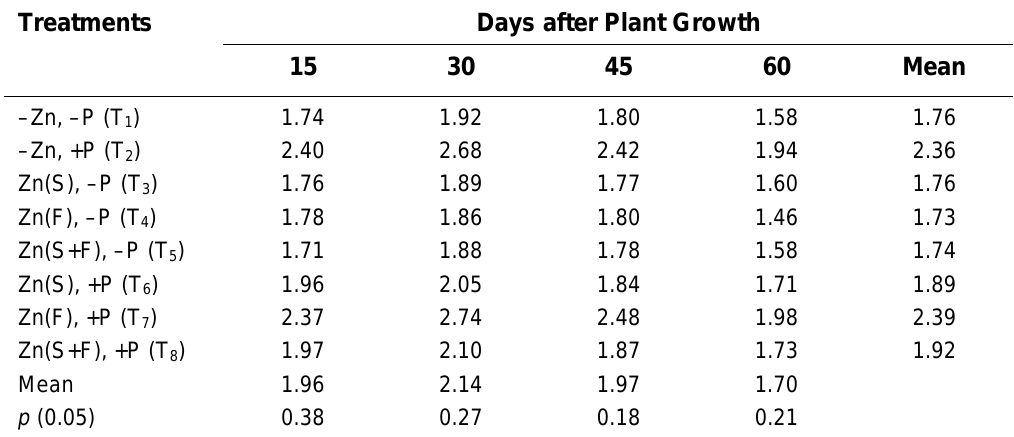
Interaction Effect Between P and Zn on the P Content (mg/kg) in Plant